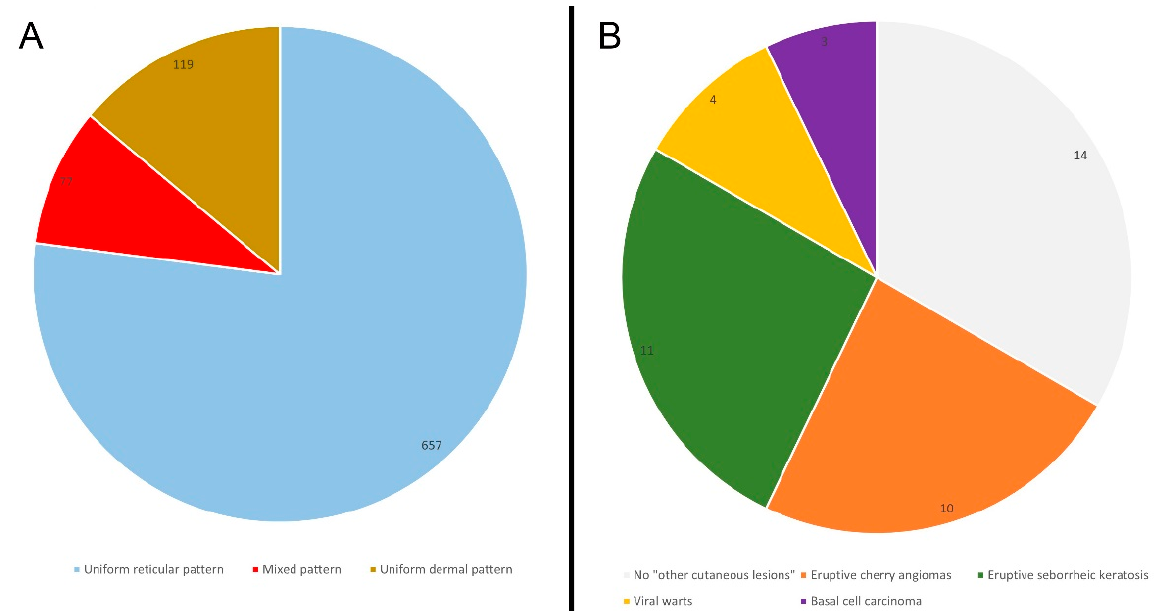
Figure 1. Cutaneous lesions observed in patients with Lynch syndrome (LS) ( A ) . A pigmented lesion with a typical uniform reticular pattern ; ( B ) a pigmented lesion with a mixed pattern composed of a central structureless area surrounded by a network; ( C ) a dermal nevus showing a uniform and unspecified dermal pattern; ( D ) a cherry angioma with uniform reddish pattern ; ( E ), pigmented basal cell carcinoma and ( F ) uniform dermal pattern in a blue nevus.